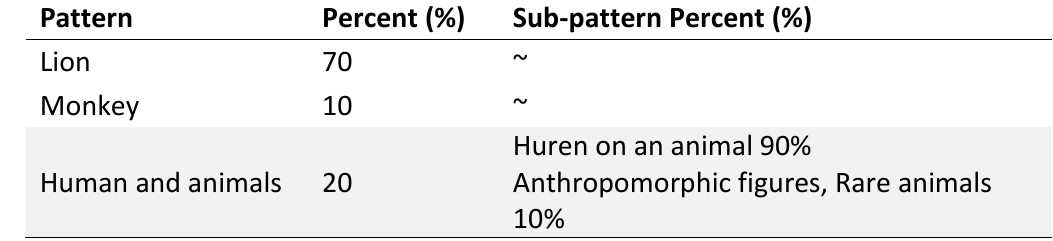
Table 1. Proportion of different patterns in Shaanxi province done by Wang & Dang (1985)